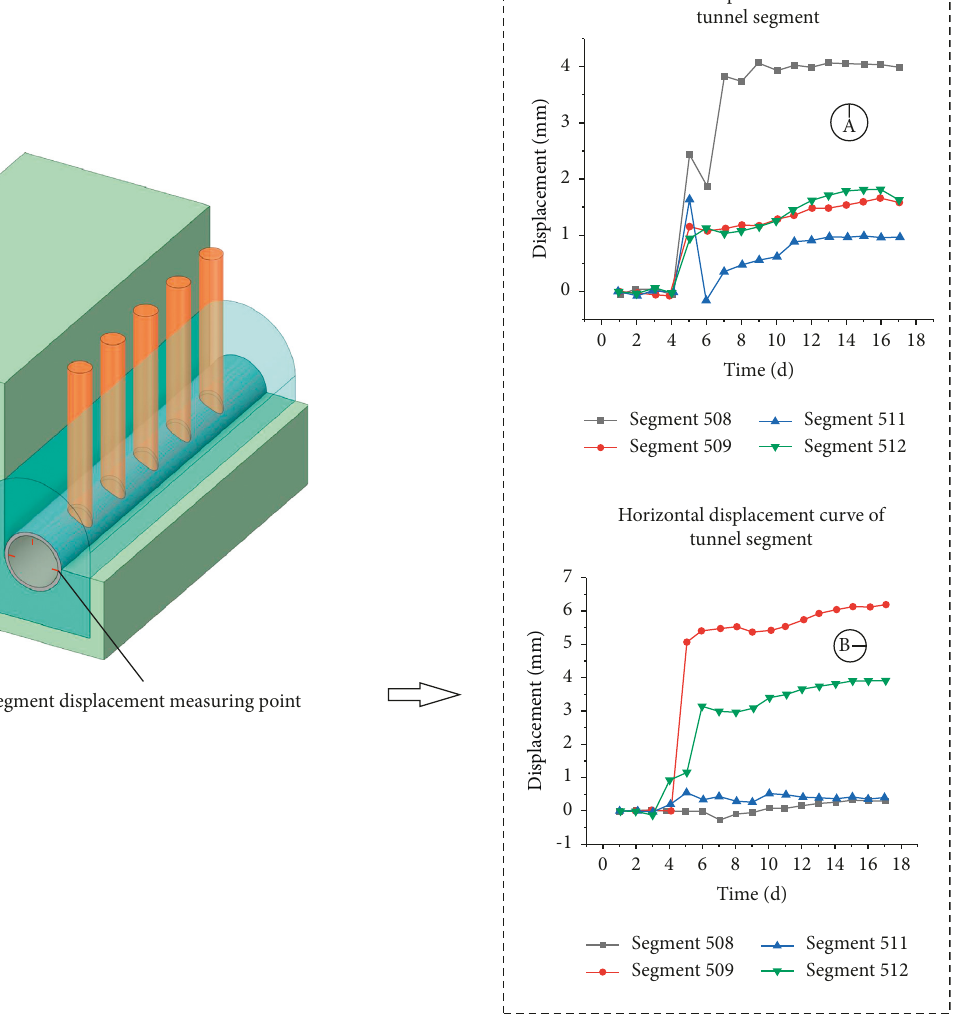
Figure 16: Vertical and horizontal displacement curves of tunnel